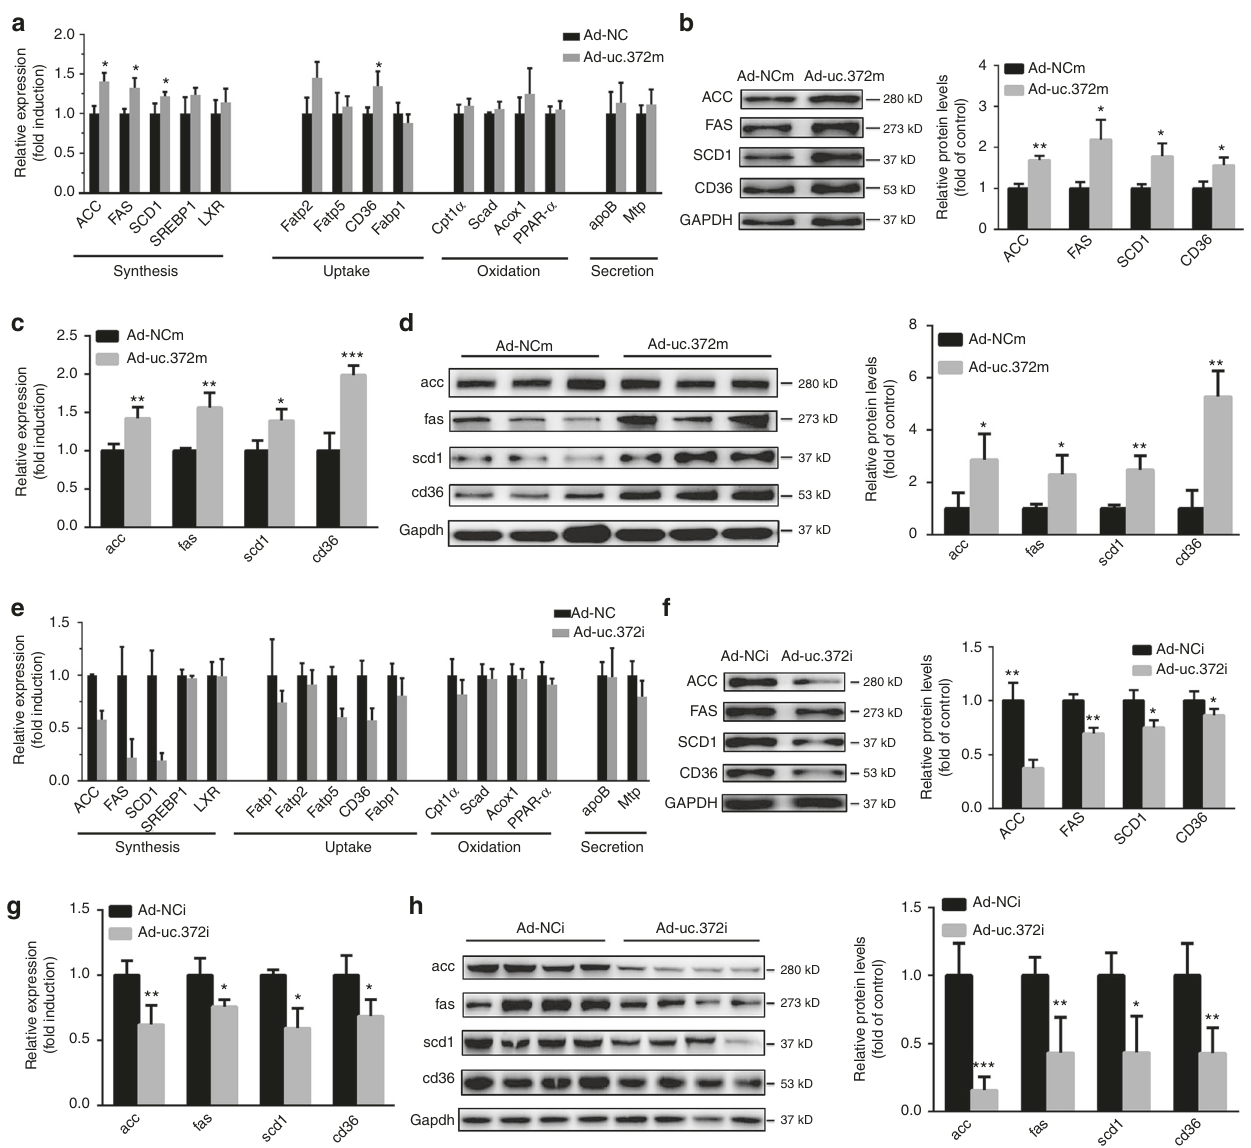
Fig. 3 Uc.372 promotes the expression of genes related to lipid synthesis and uptake in hepatocytes. a Expression levels of genes related to lipid synthesis ( ACC , FAS , SCD , SREBP1 , and LXR ), uptake ( Fatp1 , Fatp2 , Fatp5 , Fabp1 , and CD36 ), oxidation ( Cpt1a , Scad , Acox1 , and PPAR-a ), and secretion ( apoB and Mtp ) in HepG2 cells transfected with Ad-uc.372m or Ad-NCm for 48 h ( n = 3). b Protein levels of ACC, FAS, SCD1, and CD36 in HepG2 cells transfected with Ad- uc.372m or Ad-NCm for 48 h, as analyzed by western blot (representative blots from three similar experiments) ( n = 3). c Expression levels of acc , fas , scd1 , and cd36 in the liver of 6- to 8-week-old C57BL/6J mice injected with Ad-uc.372m or Ad-NCm for 7 days ( n = 3). d Protein levels of acc, fas, scd1, and cd36 in the liver of 6- to 8-week-old C57BL/6J mice injected with Ad-uc.372m or Ad-NCm for 7 days ( n = 3). e Expression levels of genes related to lipid synthesis, uptake, oxidation, and secretion in HepG2 cells transfected with Ad-uc.372i or Ad-NCi for 48 h ( n = 3). f Protein levels of ACC, FAS, SCD1, and CD36 in HepG2 cells transfected with Ad-uc.372i or Ad-NCi for 48 h in the presence of an O/P mixture (representative blots from three similar experiments) ( n = 3). g Expression levels of acc , fas , scd1 , and cd36 in the liver of 10-week-HFD-fed mice after tail vein injection of Ad-uc.372i or Ad-NC for 7 days ( n = 3). h Protein levels of acc, fas, scd1, and cd36 in the liver of 10-week-HFD-fed mice after tail vein injection of Ad-uc.372i or Ad-NC for 7 days ( n = 3). Data are mean ± SEM; * P < 0.05; ** P < 0.01; *** P < 0.001 vs. control group (Student ’ s t